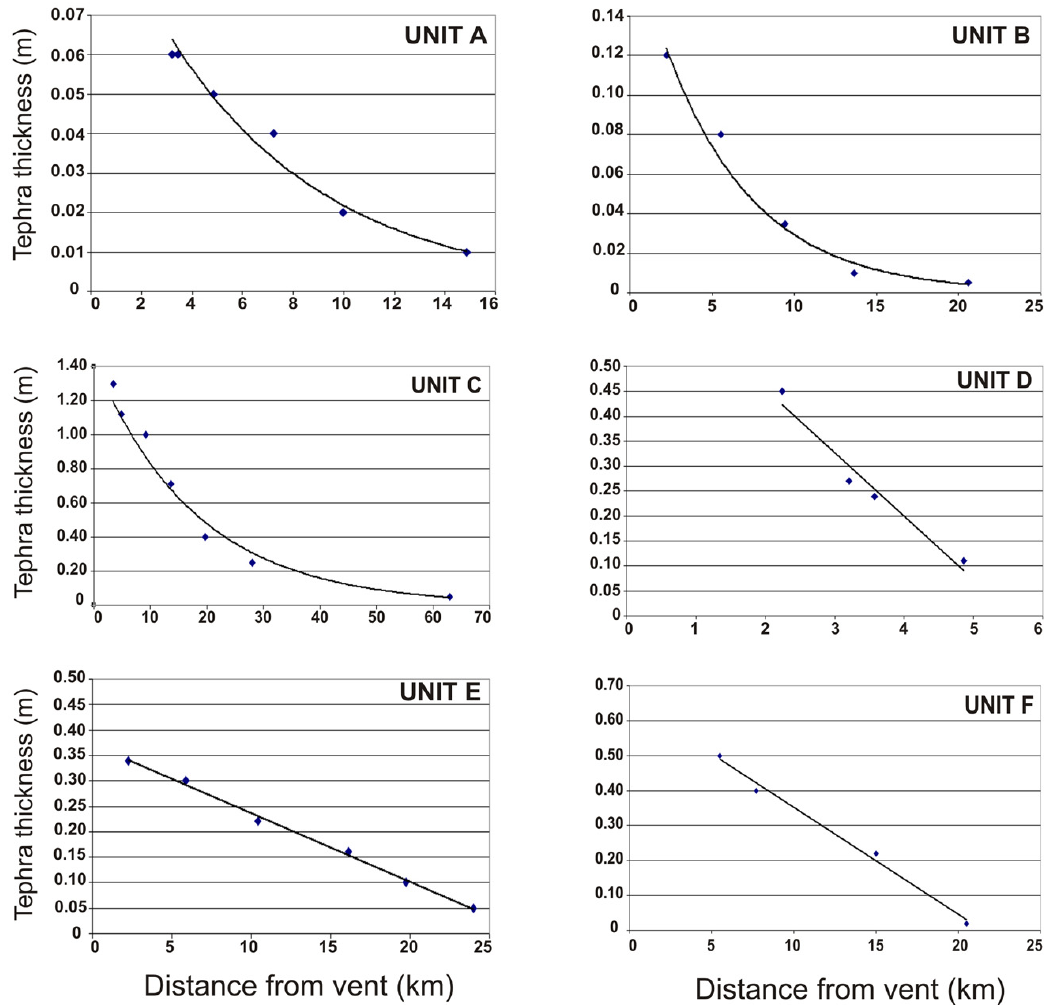
Figure 4. Thicknesses (m) of the individual 122 BC Etna fallout units (as indicated) according to their distance from the vent (km) along the dispersal axis.